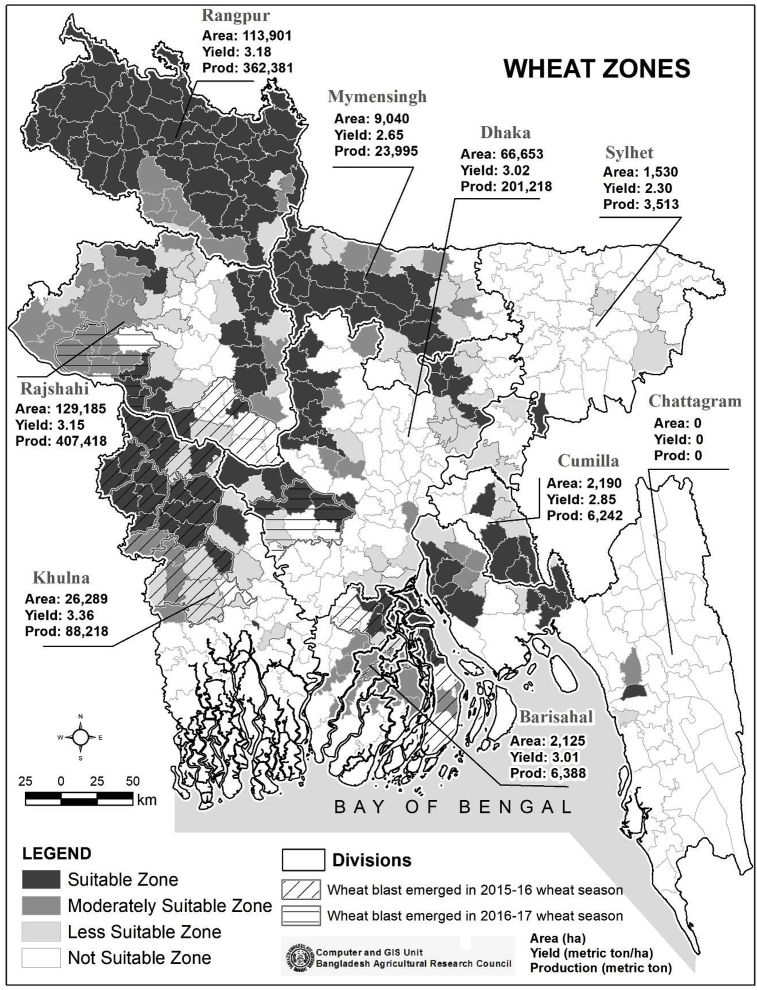
Wheat in Bangladesh: Suitability zones, production statistics by division (2017–18) and wheat blast first incidence (2015–16 or 2016–17). Sources: BARC (2019); BBS (2019); CIMMYT (2017); Islam et al. (2016).